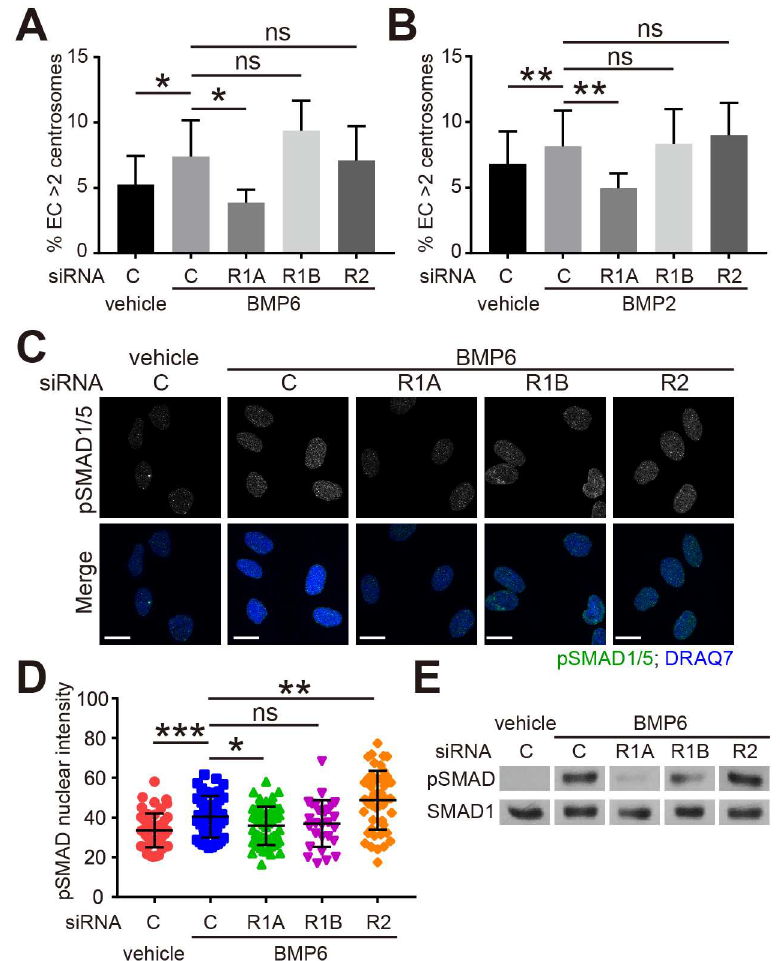
Fig 2. BMP-induced centrosome over-duplication is dependent on BMPR1A. (A, B) Frequency of excess centrosomesin indicatedsiRNA-treated HUVEC culturedwith vehicleor 200 ng/ml of BMP6 (A) or BMP2 (B) for 4 days. C, non-targeting control siRNA; R1A, BMPR1A siRNA; R1B, BMPR1B siRNA; R2, BMPR2 siRNA. (C) Representative images of HUVEC treated with indicatedsiRNA and vehicleor BMP6 and stainedfor phospho-SMAD1/5 (pSMAD1/5, green) and nucleus(DRAQ7, blue). Cells were starved in Opti- MEM for 4 hr, followedby 30 min treatment with vehicleor BMP6. Only the nuclear pSMAD1/5 is shown (see Methods for detailsof mask). (D) Quantification of nuclear pSMAD1/5 in HUVEC treated as indicated.(E) Western blot of phospho-SMAD1/5 (pSMAD) and total SMAD1 in HUVEC treated as indicated. Cells were starved in Opti-MEM for 4 hr, then treated with vehicle or BMP6 for 30 min. Error bars, standard deviationfrom mean. Statistics: two-tailedpaired(A, B) or unpaired(D) Student’s t-test. ns, not significant; * , p (cid:20) 0.05; ** , p (cid:20) 0.01; *** , p (cid:20) 0.001.Scale bars: 10 μ